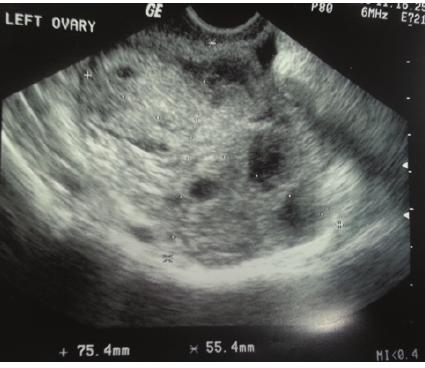
Figure 1: Left ovary measuring 75.4 mm × 55.4 mm. Figure 2: Right ovary measuring 85.7 mm × 54.3